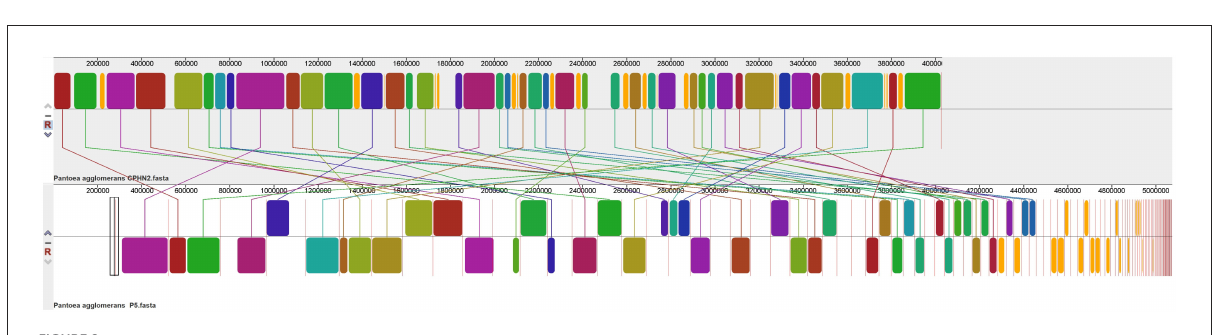
FIGURE2 FDAARGOS 1447 and P. agglomerans CPHN2 genomes are compared using Mauve 2.3.1